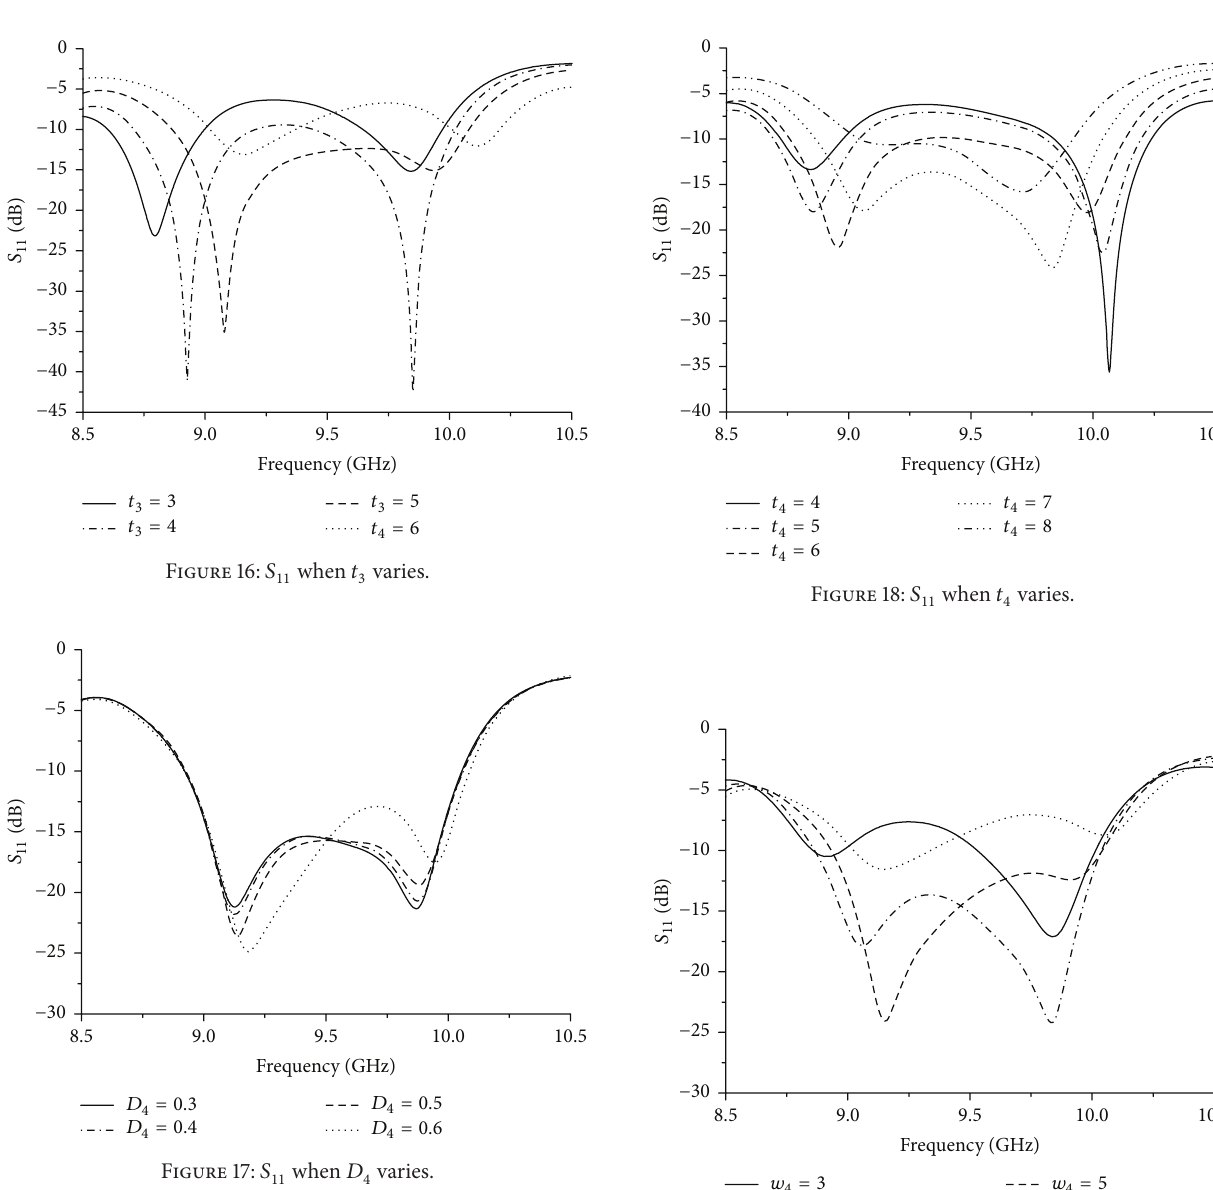
Figure 19: 𝑆 11 when 𝑤 4 varies.